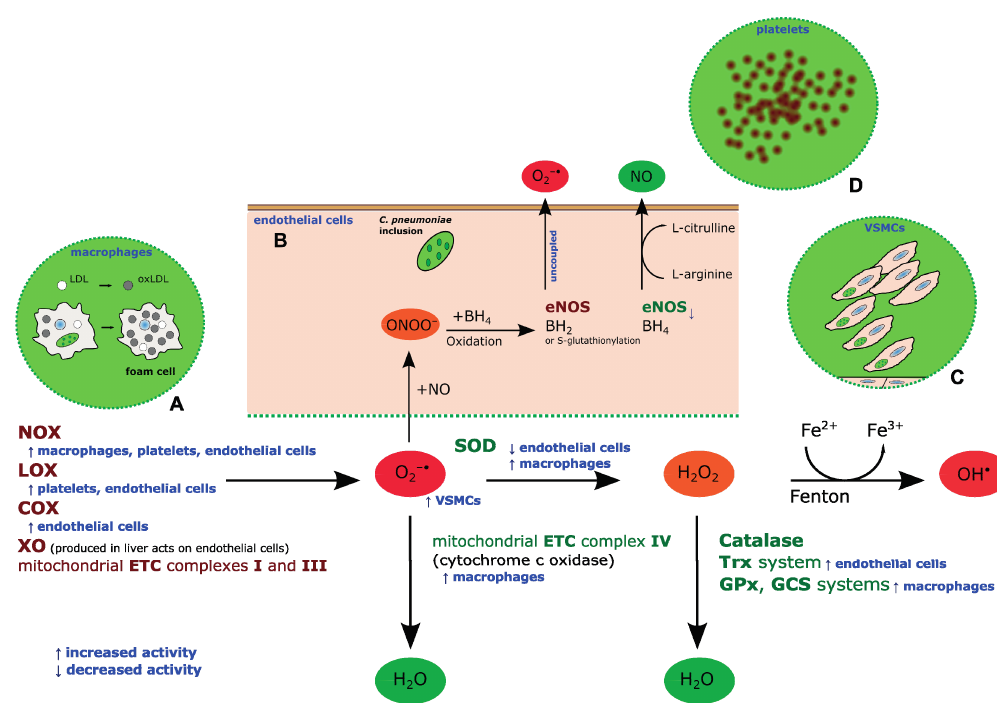
Figure 1. ROS generation and inactivation in the vascular wall and the contribution of C. pneumoniae . Generally, superoxide anion (O 2 − · ) can be produced by NADPH oxidase (NOX), lipoxygenases (LOX), cycloxygenases (COX), xanthine oxidase (XO) and mitochondrial electron transport chain (ETC) complexes I and III during the oxidative respiration. O 2 − · can be disproportionated to hydrogen peroxide (H 2 O 2 ) by superoxide dismutase (SOD). H 2 O 2 can spontaneously convert to hydroxyl radical (OH · ) via the Fenton reaction. Alternatively, H 2 O 2 can be detoxified to water via catalase, glutathione peroxidase (GPx) and γ glutamylcysteine synthase (GCS) or thioredoxin (Trx) systems. O 2 − · can also be directly detoxificated into water by cytochrome c oxidase (mitochondrial ETC complex